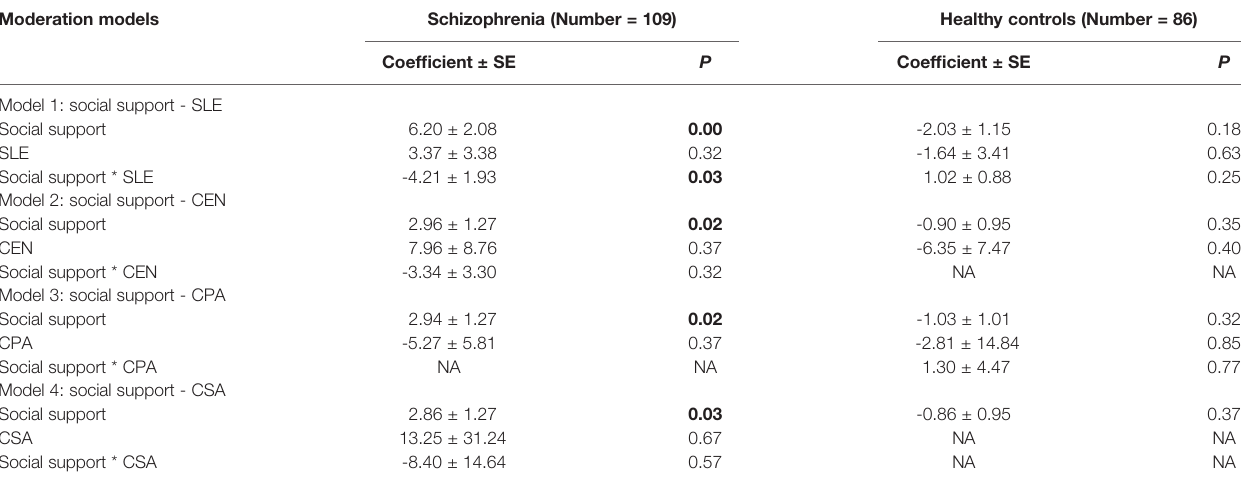
TABLE 3 | Moderation models for